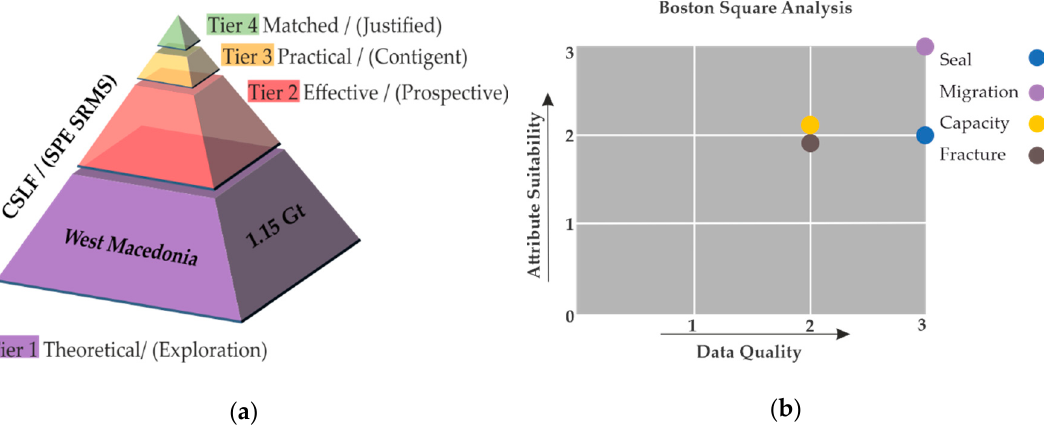
Figure 6. ( a ) CSLF four-tier capacity pyramid presenting the relationship between Theoretical, Effective, Practical and Matched capacities ( b ) Boston Square analysis for West Macedonia, Grevena sub-basin